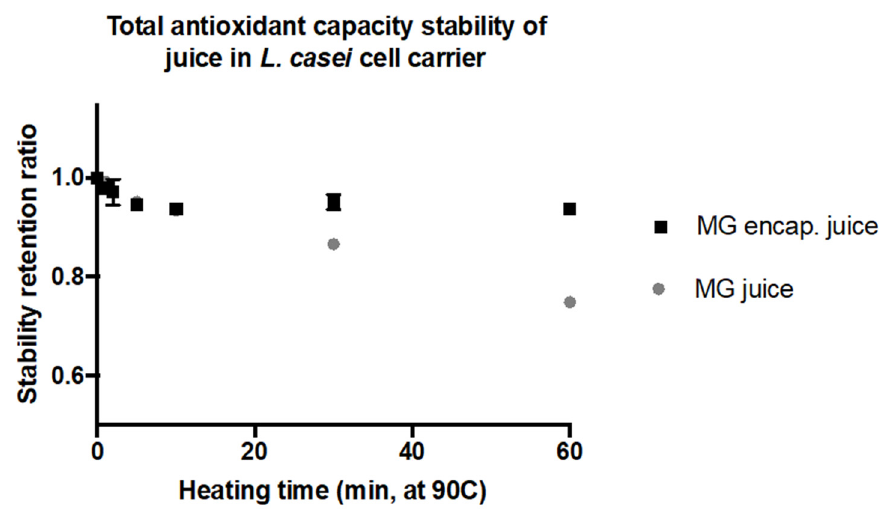
Figure 4. Retention of antioxidant content of phenolic bioactives from grape juice upon selected heat treatment both with and without encapsulation in the selected cell-carrier, after treatment juice samples were extracted with 85% methanol and quantified using the FRAP assay.